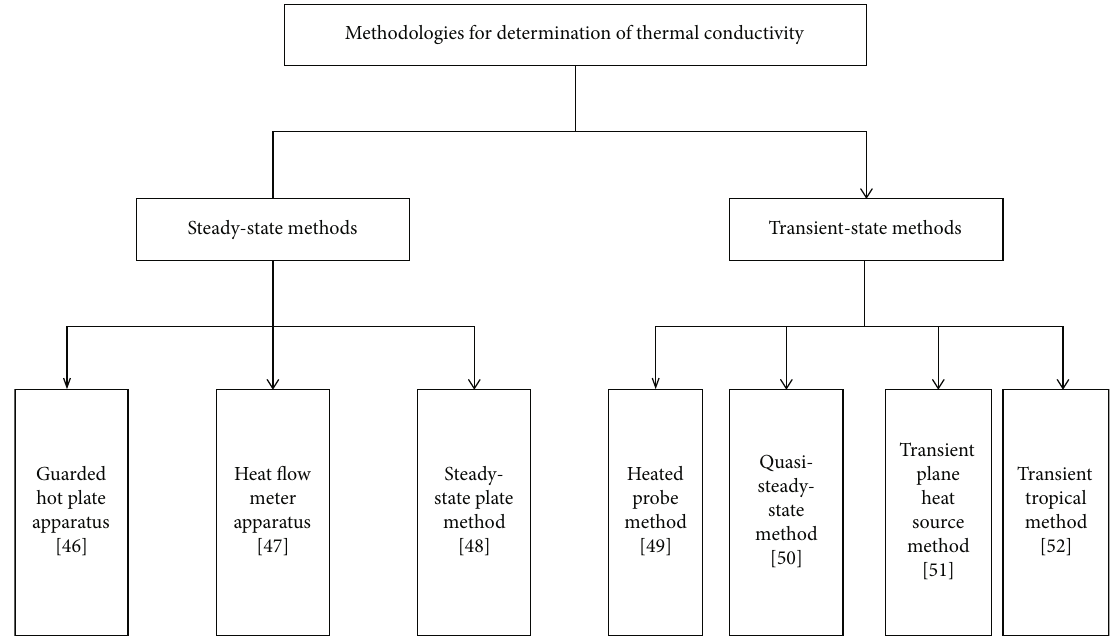
Figure 3: Methodologies for determination of thermal conductivity [46 –